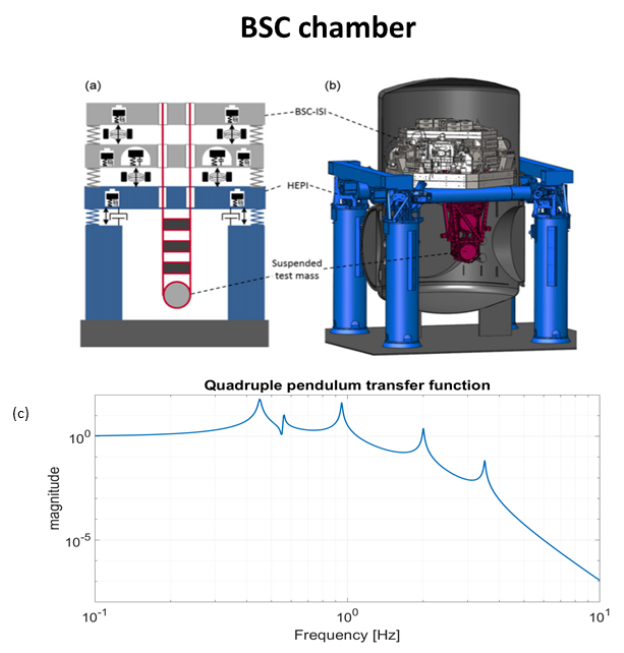
Figure 7. Schematic model ( a ) and technical drawing ( b ) of the BSC chamber supporting the LIGO test masses [17]. For completeness, panel ( c ) shows the quadruple pendulum mechanical transfer function from the ground to the test mass along the longitudinal degree of freedom. This transfer function was reconstructed following Figure 5 in